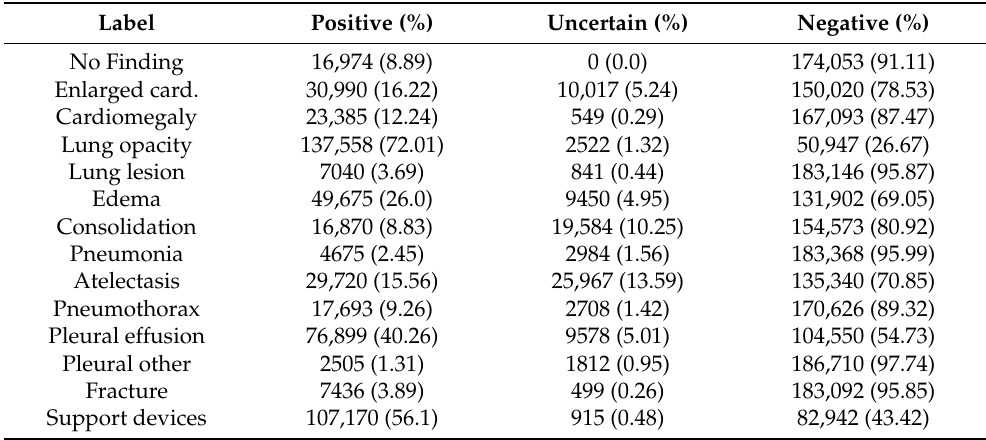
Table 1. Absolute frequencies of positive, uncertain, and negative samples for each finding (relative frequencies are reported in parentheses) in the CheXpert dataset ( n = 191,027).